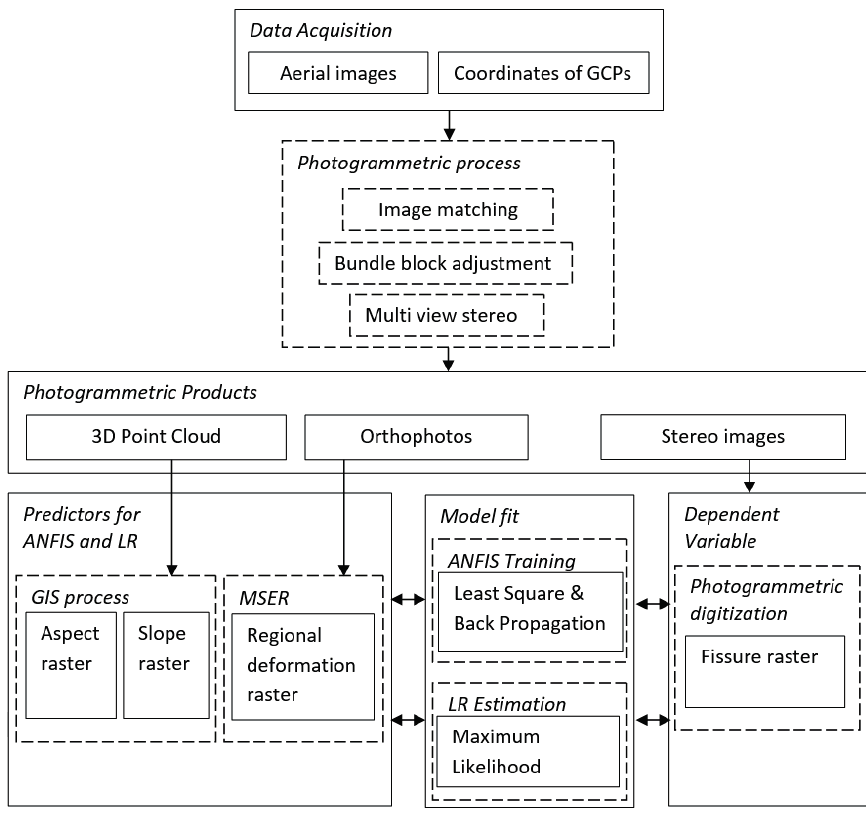
Figure 6. Data processing